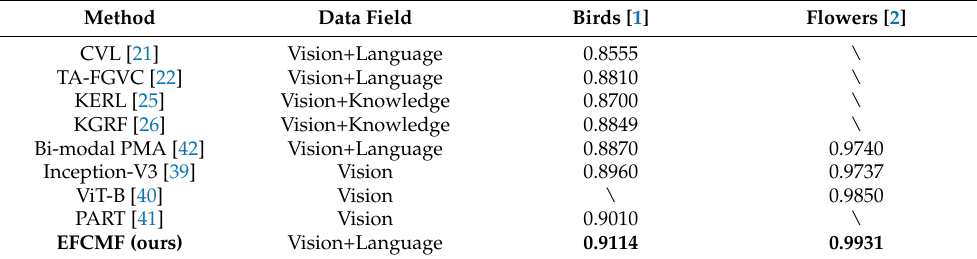
Table 5. Comparison of the accuracy of each